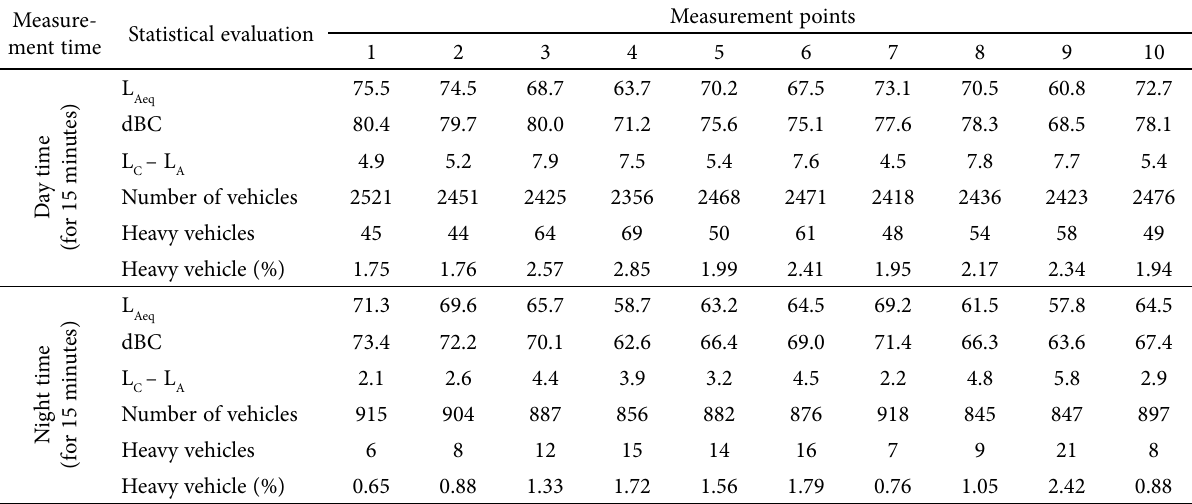
Table 3. Noise measurement results and number of vehicles Mea